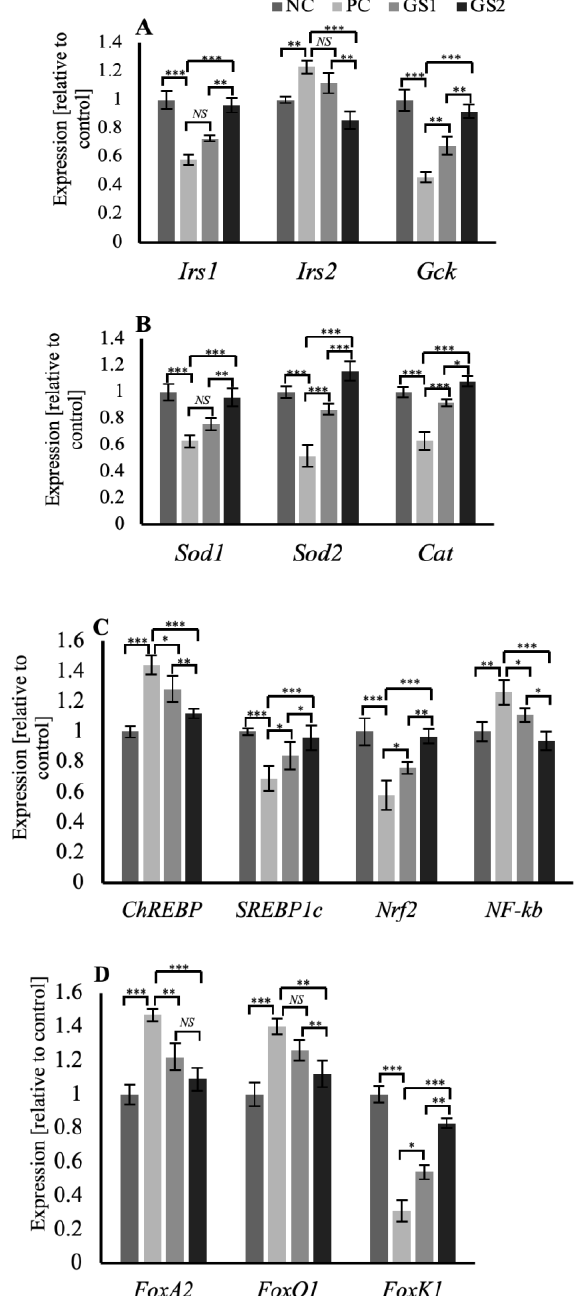
Figure 7. Mean values of mRNA expression of different genes in the liver of different treatment groups. ( A ) Irs1, Irs2 , and Gck ( B ) Sod1, Sod2, and Cat . ( C ) ChREBP, SREBP1c, Nrf2, and Nf-kB . ( D ) FoxA2, FoxO1, and FoxK1 . Negative control (NC), positive control (PC), Gymnema sylvestre 250 mg (GS1), Gymnema sylvestre 500 mg (GS2). NS : non-significant, ( * ): p ≥ 0.05, ( ** ): p ≥ 0.01, ( *** ): p ≥ 0.001.